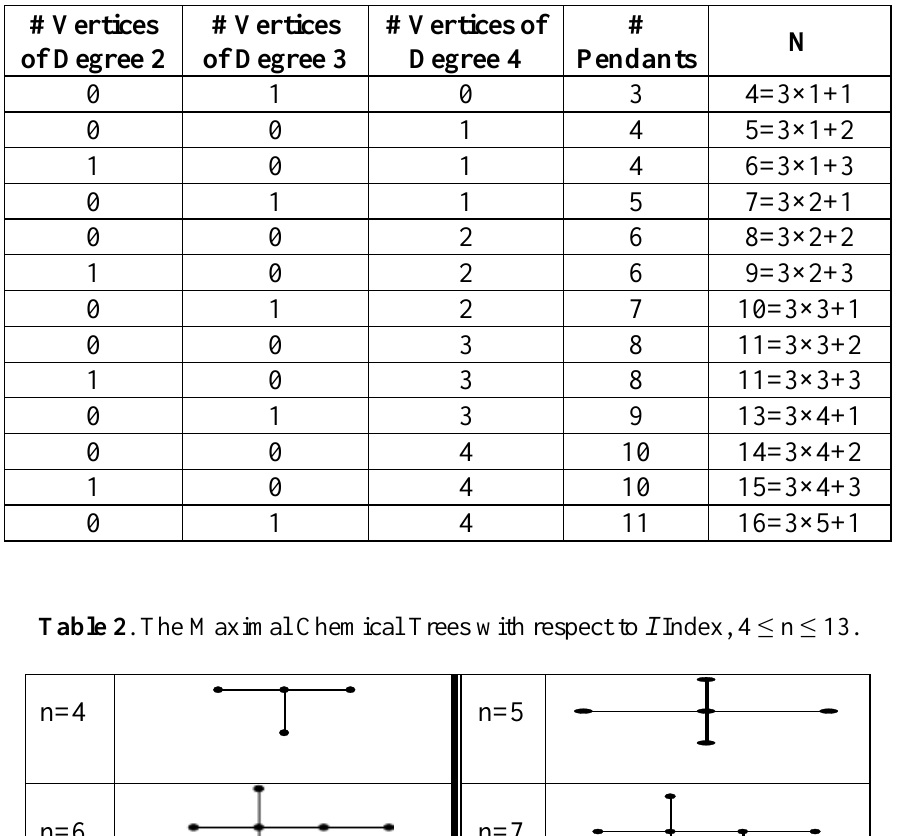
Table 1. The Number of Vertices of Each Degree in n - Vertex Chemical Trees, 4 ≤ n ≤ 16.